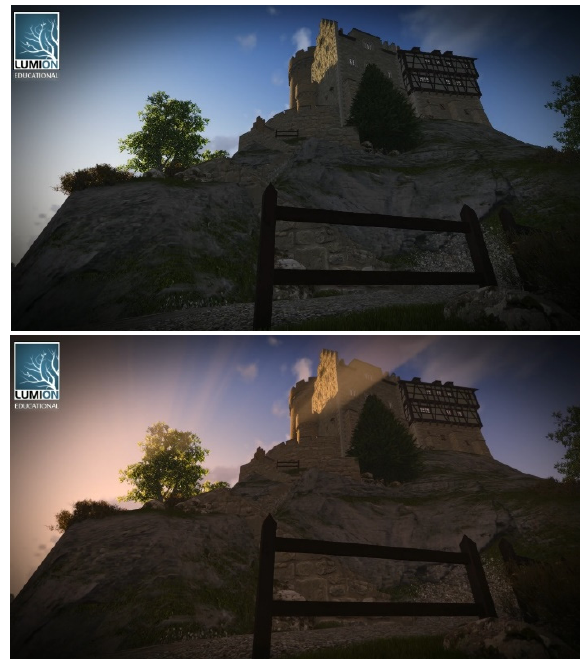
Figure 11. A frame of the opening sequence without (top) and with (bottom) volumetric sunlight and colour correction. Both